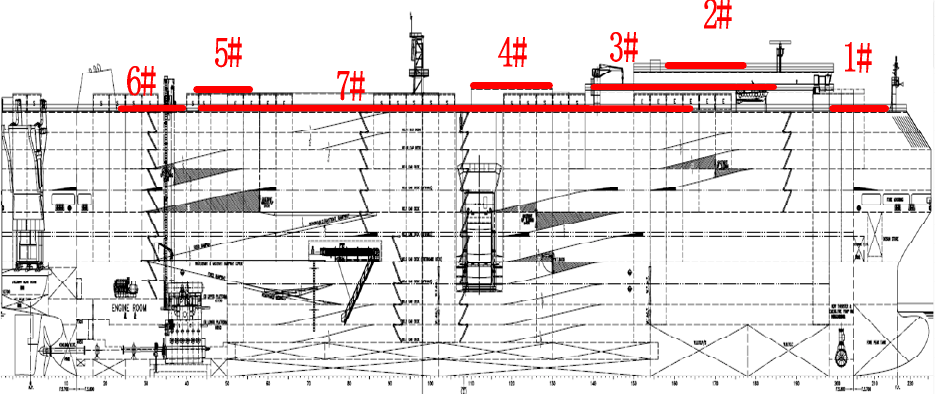
Figure 1. Seven areas for the installation of solar panels.